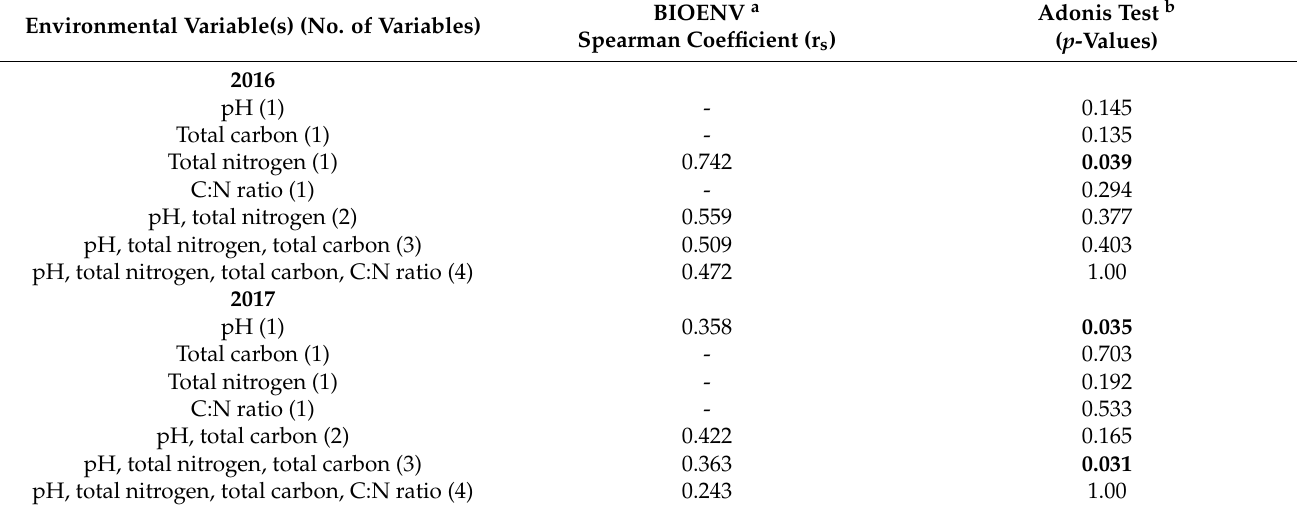
Table 7. Correlation of environmental variable with the microbial composition showing the BIOENV that best explain the community variation and Adonis test in 2016 and